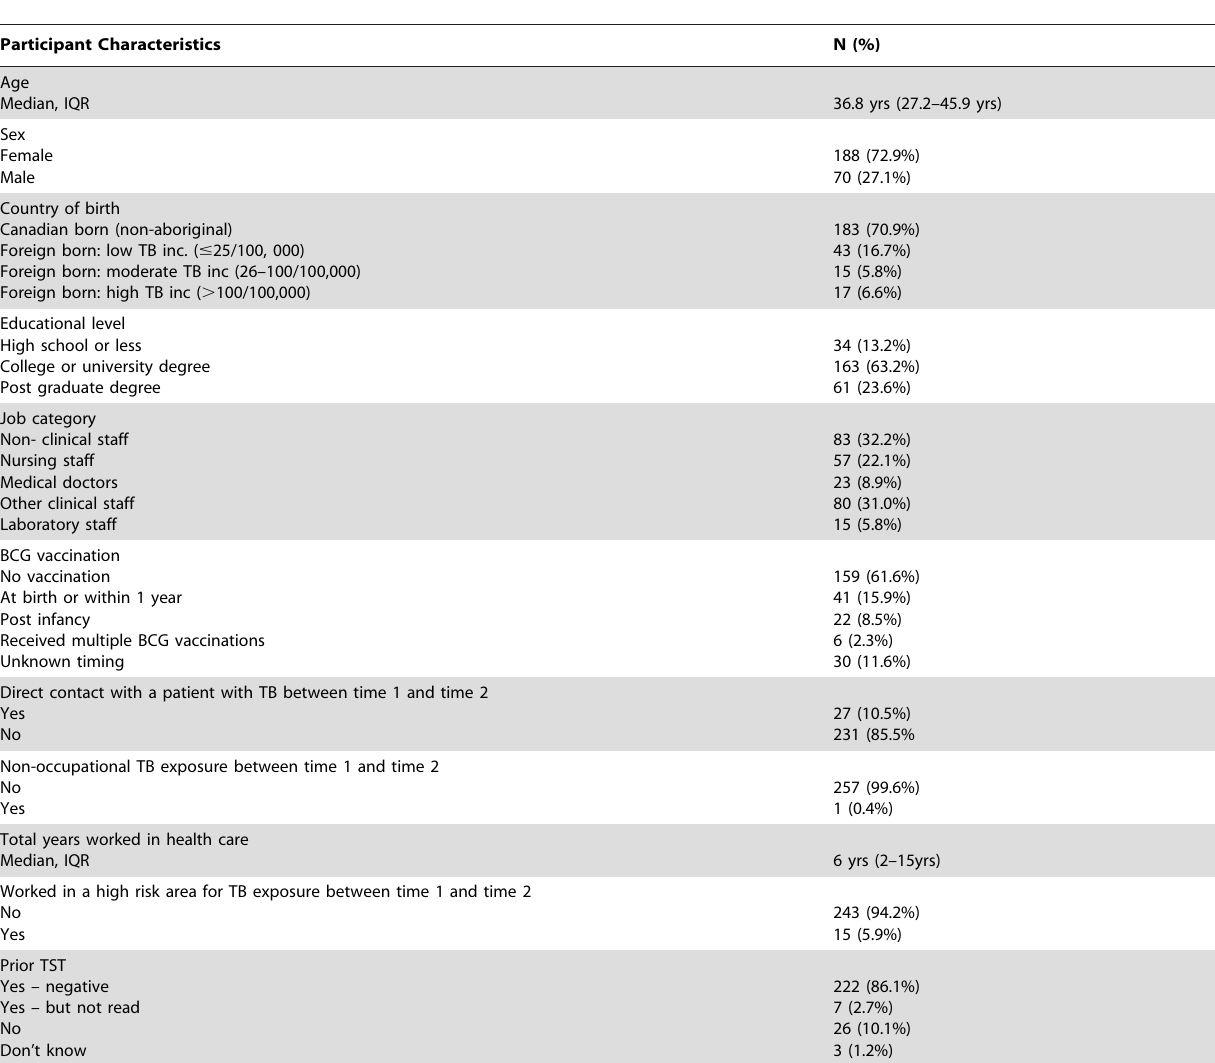
Table 1. Participant characteristics, n= 258 (at study enrolment unless otherwise stated).